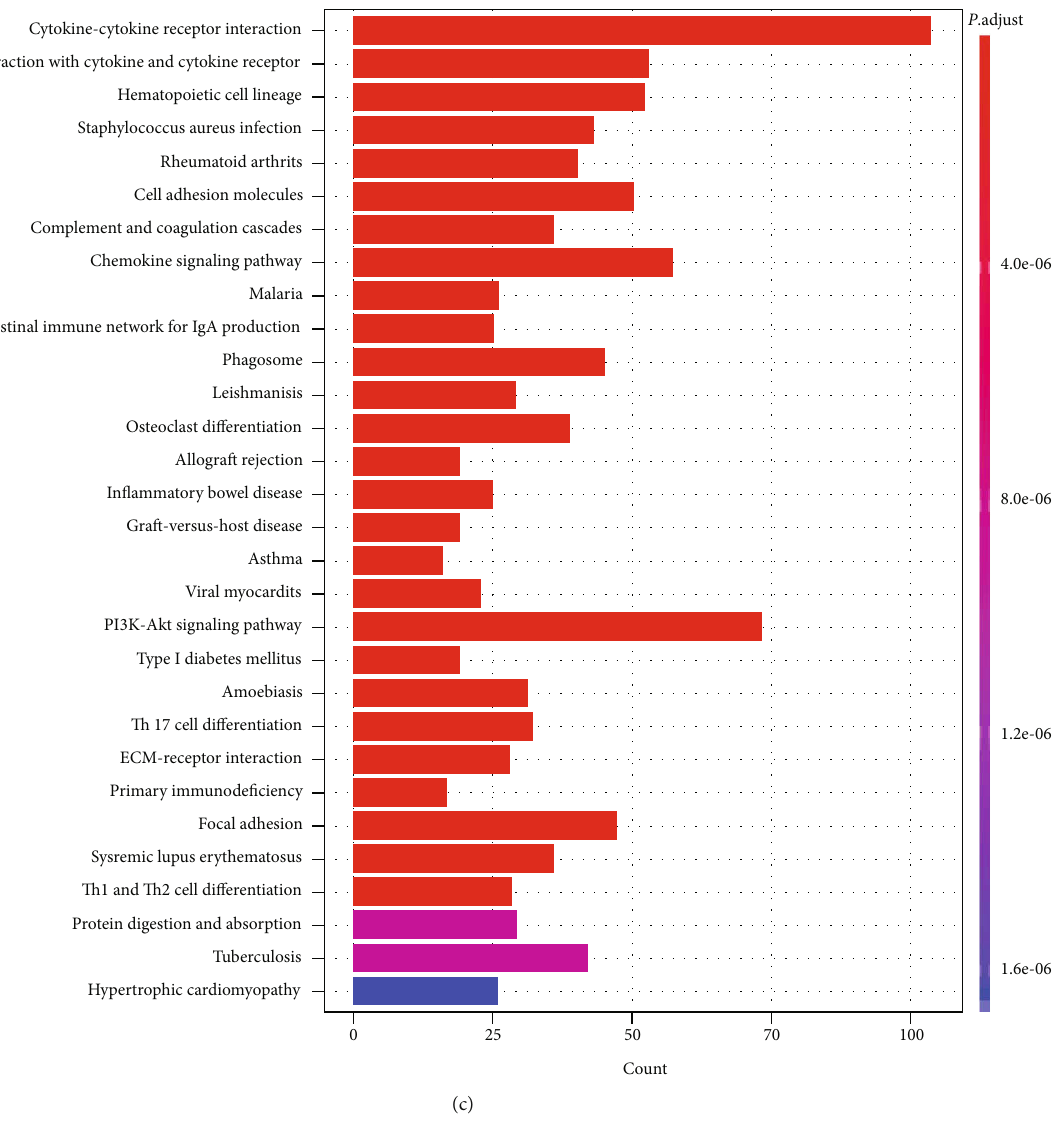
Figure 3: Heatmap, GO, and KEGG enrichment analysis. (a) DEG heatmap generated by comparing high and low subgroups of stromal score. The row names of the heatmap are the gene names, and the column names are sample IDs. The Wilcoxon rank-sum test was conducted to determine DEGs, and FDR < 0 : 05 and ∣ log 2FC ∣ >1 were considered signi fi cant. (b, c) GO and KEGG enrichment analyses of 1823 di ff erential genes, of which result with p < 0 : 05 and q < 0 : 05 , were considered signi fi